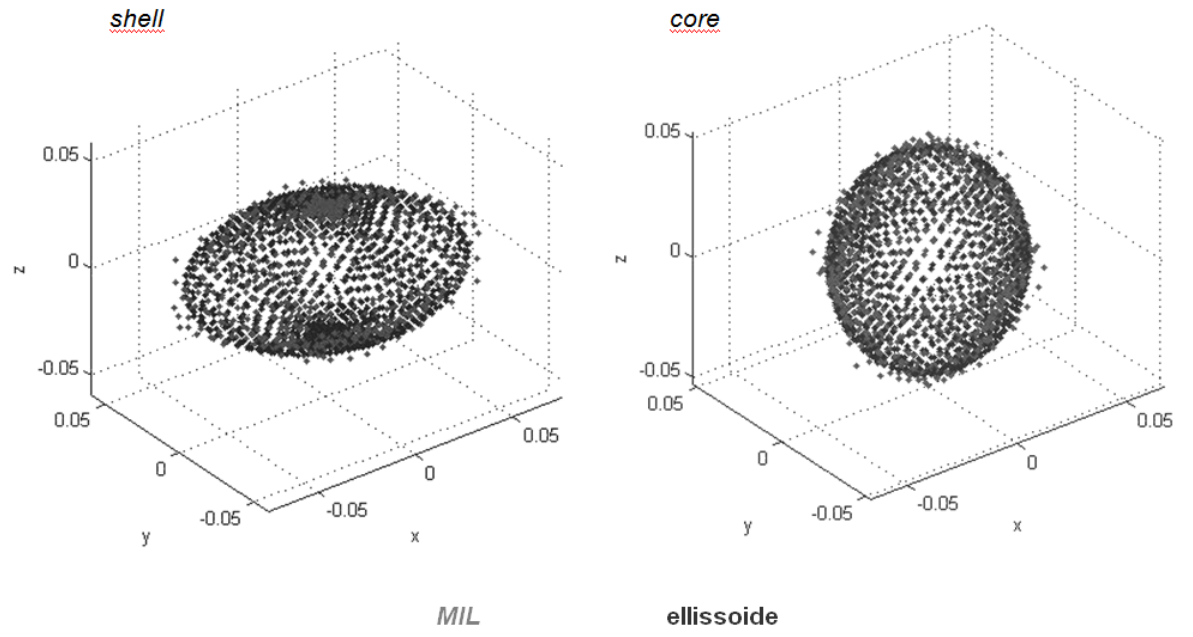
Figura 14: Rappresentazione grafica di MIL ed ellissoide del fabric tensor nelle direzioni di